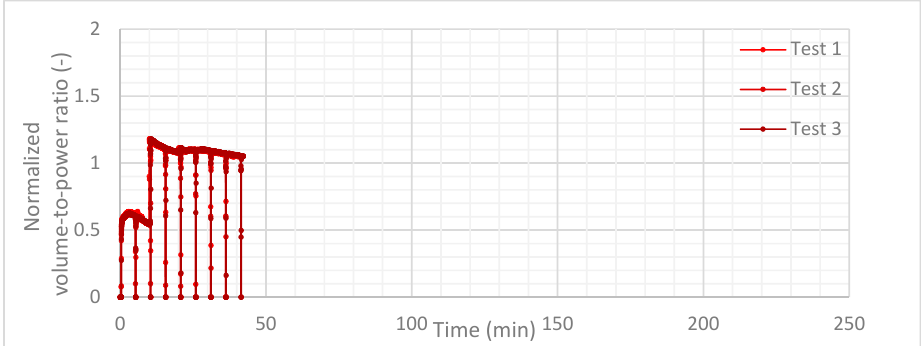
Energies 2021 , 14 , 3664